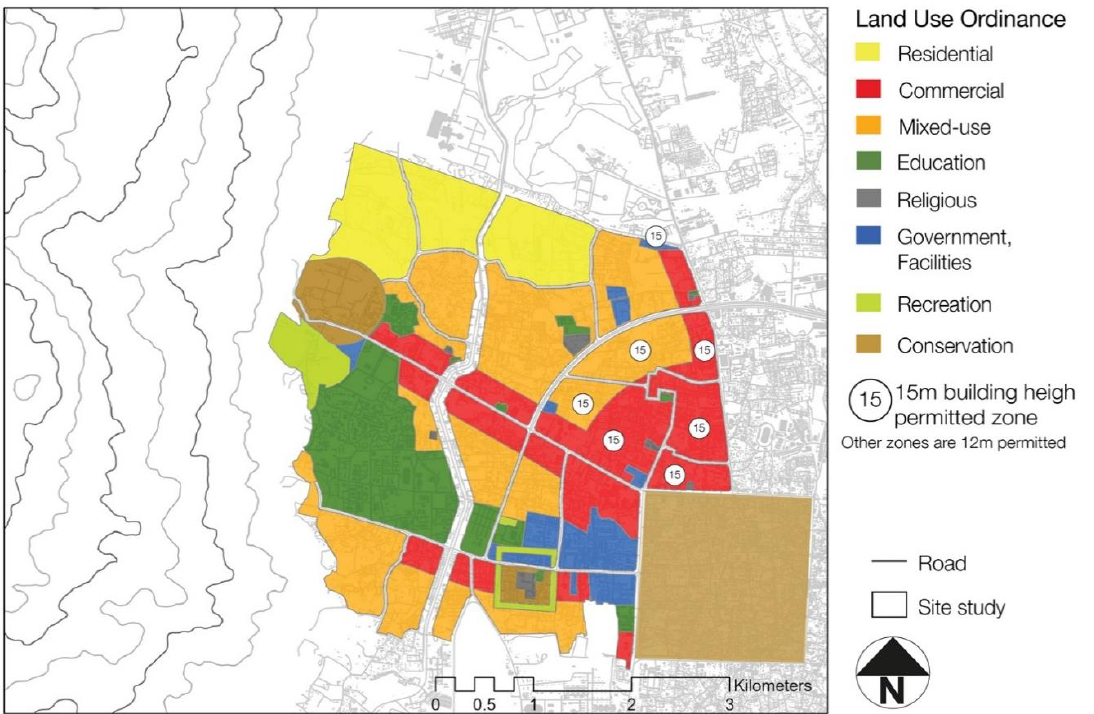
Figure 4. Land use and height zoning in the study area (Source: Authors).